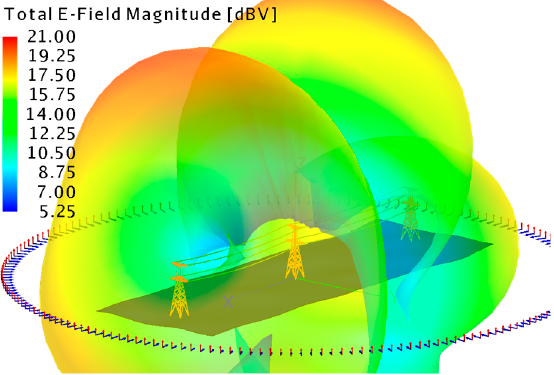
Figure 10. The three-dimensional effect of joint simulation of three-base tower array and rough ground. Table 4. Factors and levels of co-simulation.